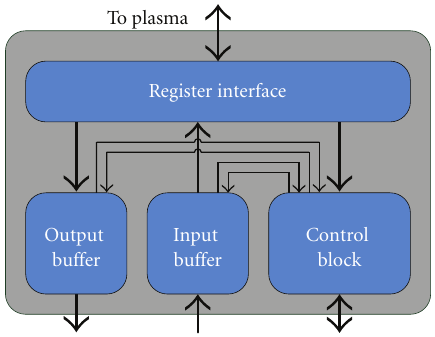
Figure 4: Virtual network